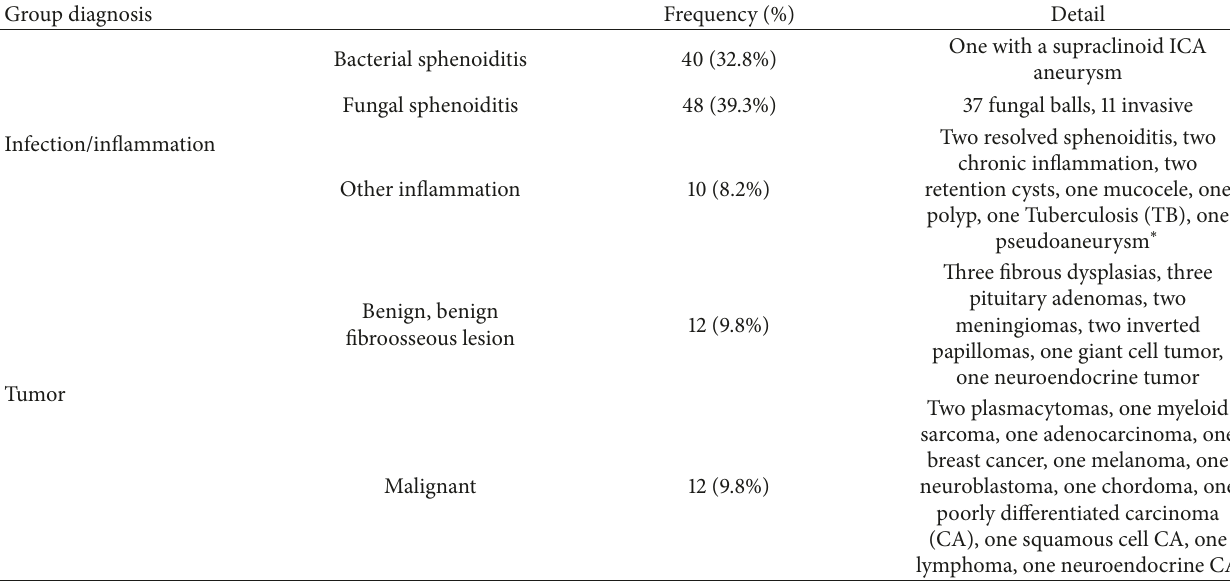
Table 1: Diagnoses of sphenoid